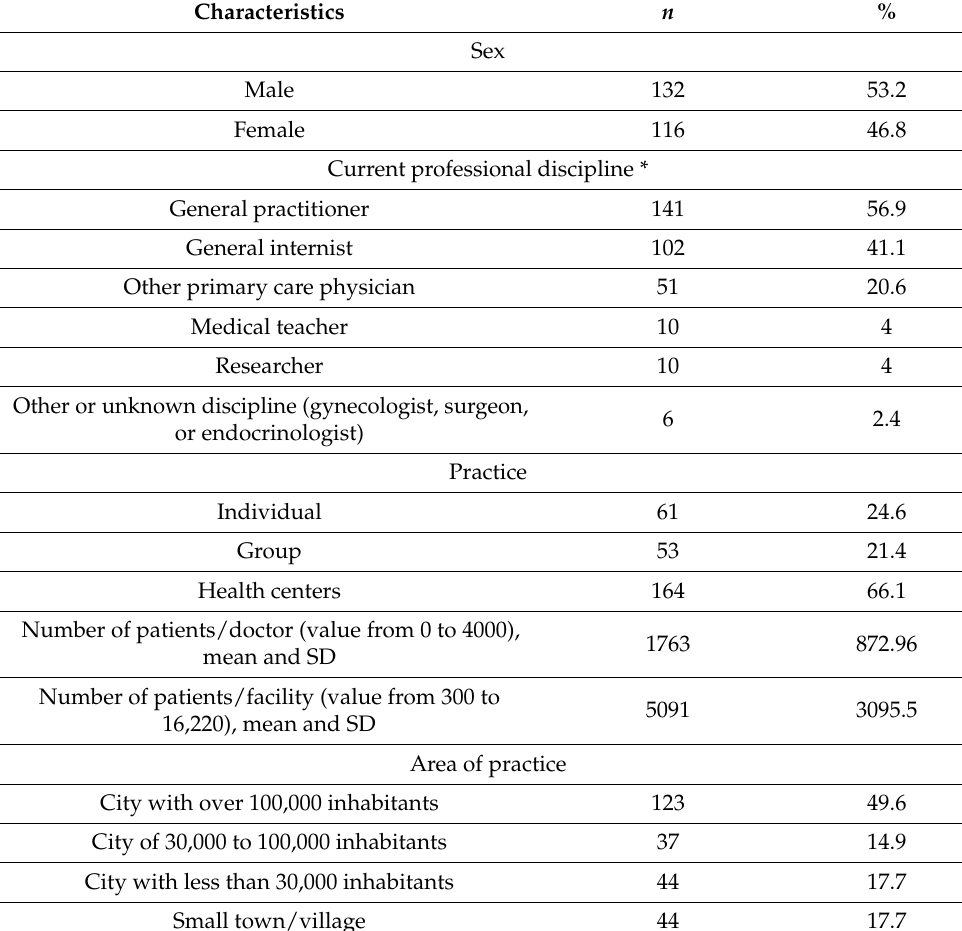
Table 2. Demographic characteristics in Polish